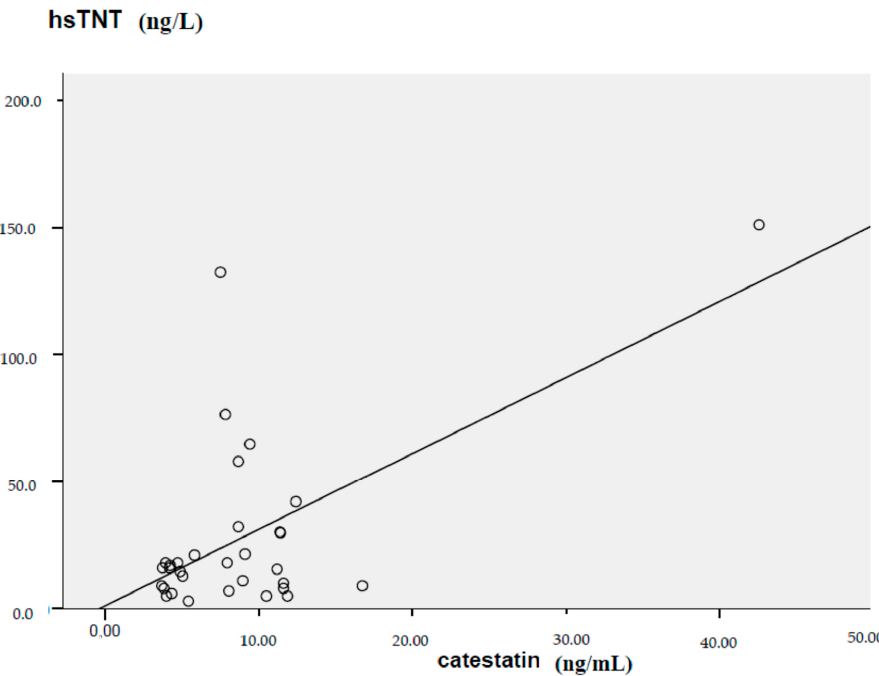
Figure 2. Linear regression plot between high-sensitivity troponin T and serum catestatin concen- tration (Y = 2.99X+ 1.17). The correlation between cardiovascular injury markers and clinical measures of the subjects is demonstrated in Table 2. Both hsTNT (high-sensitivity troponin T) and proBNP (N-terminal pro-brain natriuretic peptide) were positively correlated with COVID-19 se- verity (measured as SOFA score, MEWS score, or hospitalization days). Table 2. The correlation between cardiovascular injury markers and clinical measures of the subjects (Pearson’s test, one-tailed).